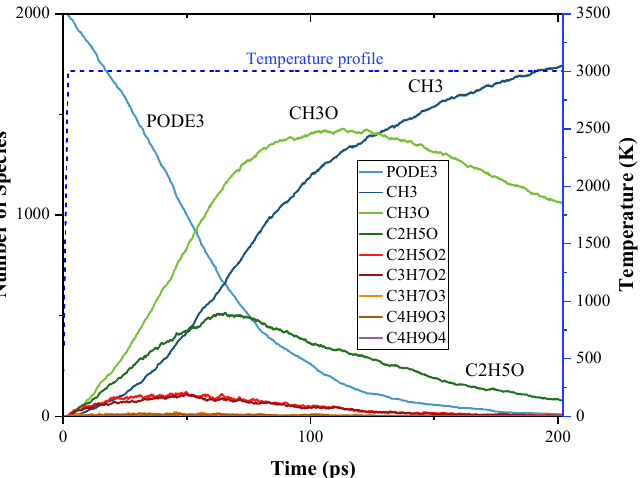
Figure 5. Time evolution of PODE3 and the products from the initial decomposition during the simulation of PODE3 pyrolysis using ReaxFF MD; temperature profile of MD simulation.